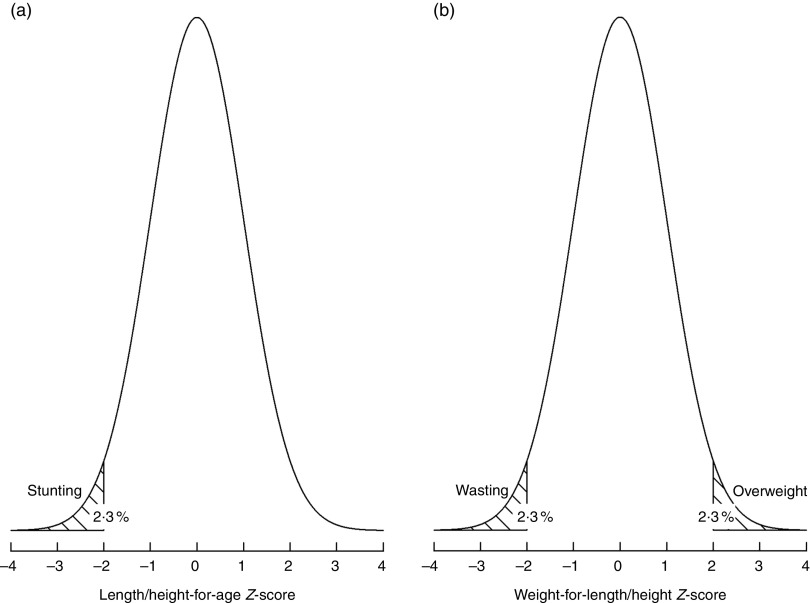
Distribution of the length/height-for-age (a) and weight-for-length/height (b) Z-scores in a healthy population: normal distribution with mean=0 and sd=1